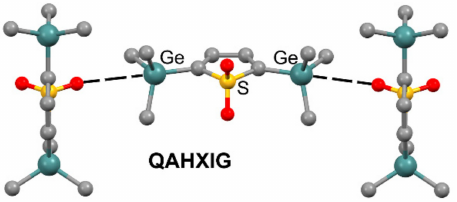
Figure 3. Ball-and-stick representation of the solid state of QAHXIG structure [69] showing the C–Ge ··· O TtBs that are represented using dashed lines. H atoms omitted for clarity.